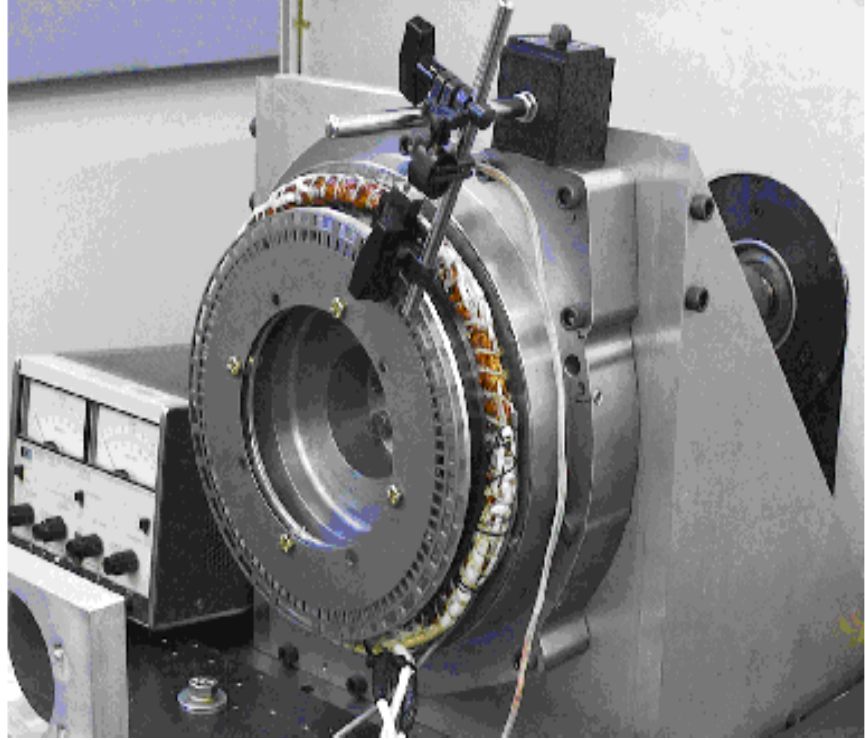
Figure 6. Off line tuning of Induction motor for gain